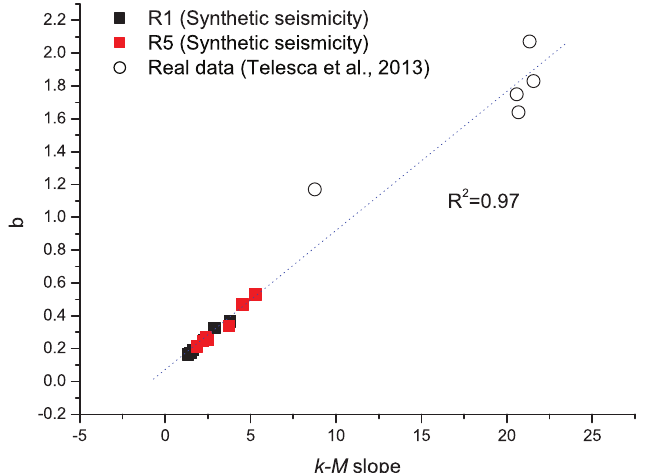
Figure 9. Relationship between the k-M slope and the b -value for the synthetic seismicity (black and red squares) compared with that for the real seismicity data (white circles) obtained by Telesca et al. [10] . The linear correlation is very good ( R 2 , 0.97).